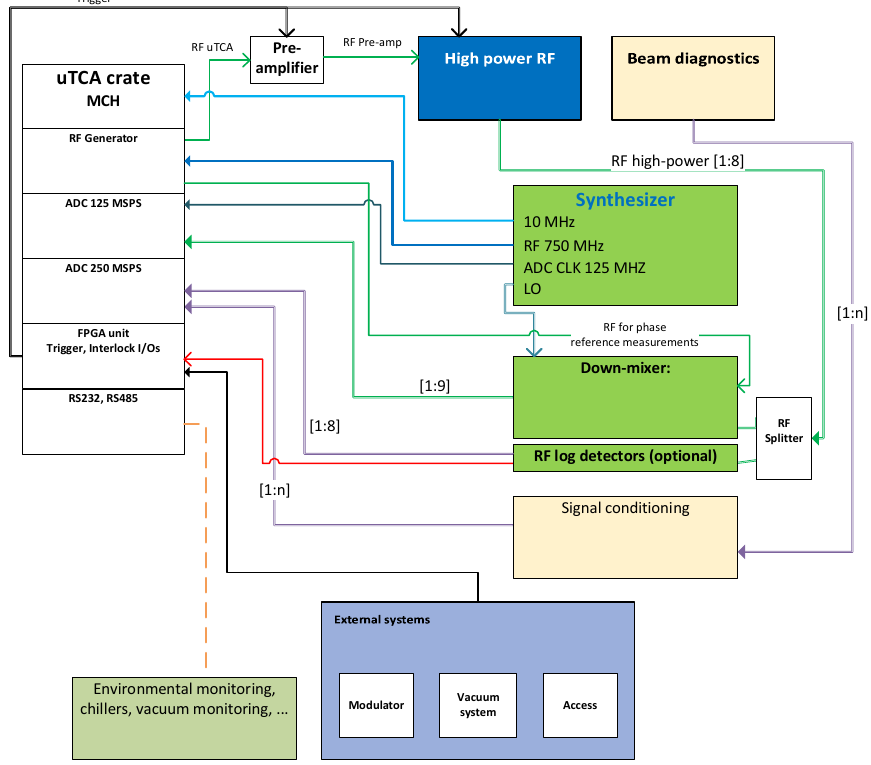
Figure 8. Global architecture of the LLRF system to be implemented using a μ TCA platform.